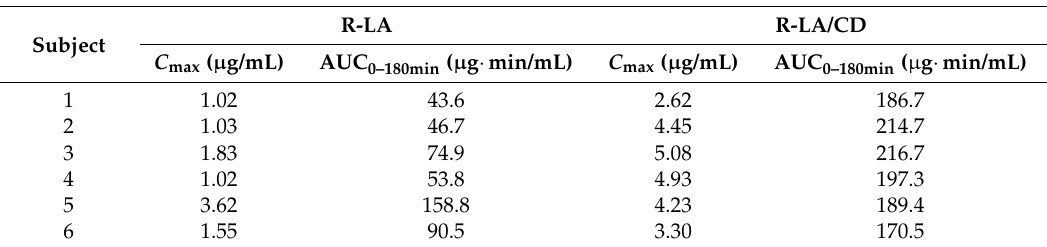
R-LA/CD (R- α -lipoic acid/ γ -cyclodextrin); R-LA (R- α -lipoic acid); C max (maximum plasma concentration); AUC (area under the plasma concentration–time curve). Table 4. Pharmacokinetic parameters for subjects orally administered with 600 mg of R- α -lipoic acid or 6 g of R- α -lipoic acid/ γ